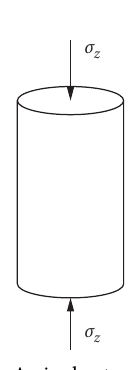
Figure 2: A single stress column.